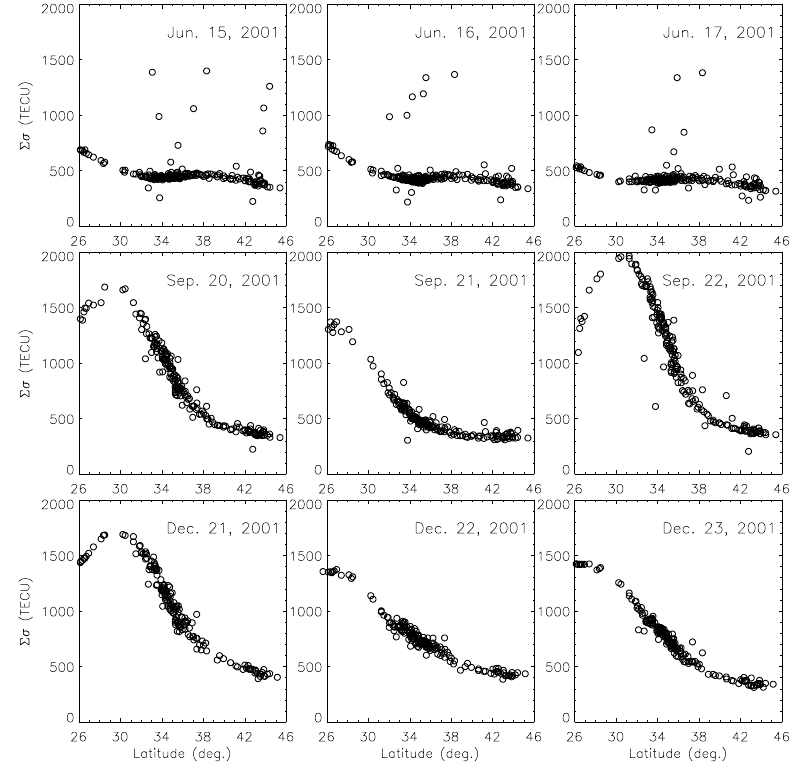
Fig. 14. The variation of 6σ with latitude for the 9 days